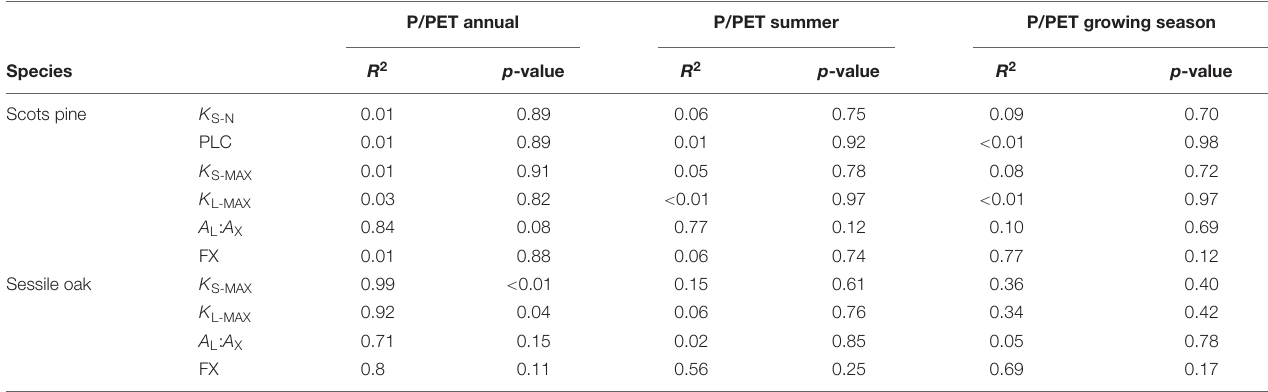
TABLE 3 | Statistics of the linear models to explain different hydraulic traits by annual, summer and growing season aridity index (P/PET) for the studied period (2011–2014) across the study